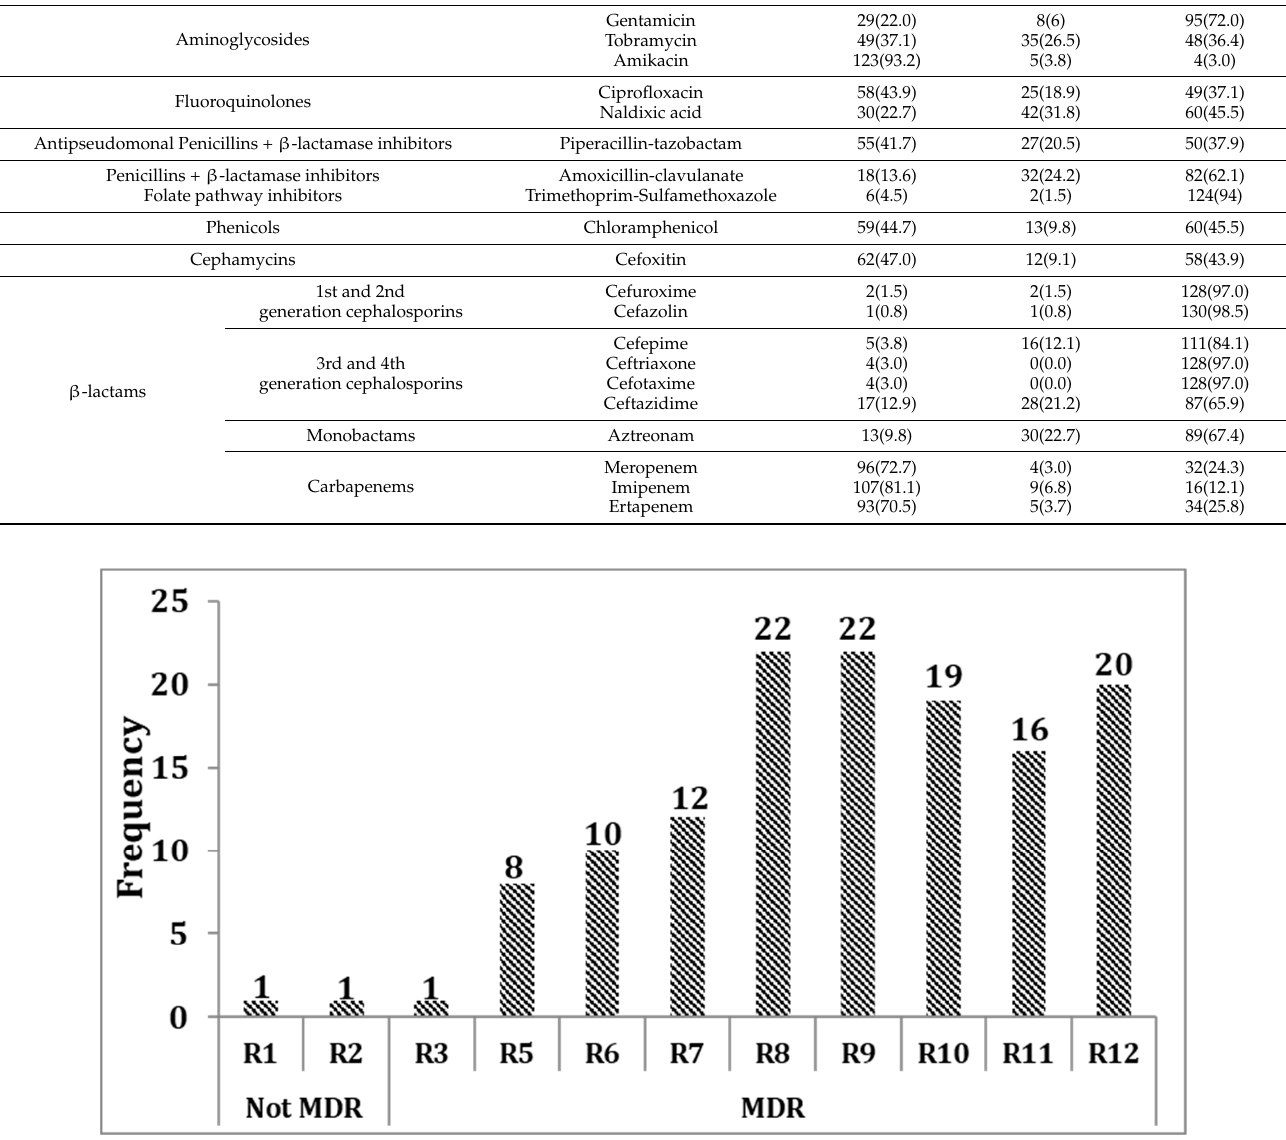
Figure 1. Multidrug resistance levels of K. pneumoniae isolates. MDR: multidrug-resistance; Rn: non-susceptibility to at least one antimicrobial agent in “ n ” antimicrobial categories, where “ n ” is the number of antimicrobial categories.